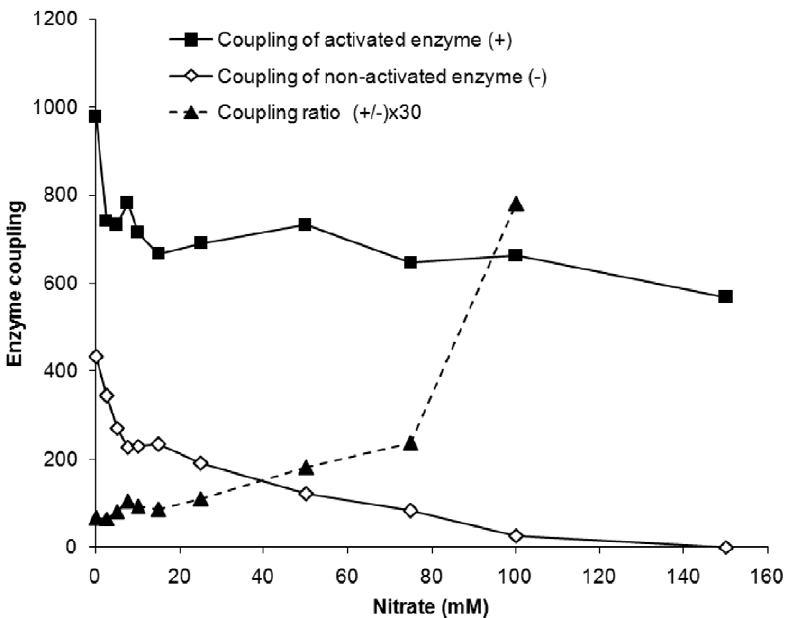
Figure 3. Nitrate inhibition of the coupling capacity of the activated and non-activated V H + -ATPase of the yeast TM revealed the higher coupling and higher stability of the activated pump. The coupling capacity (V 0 /ATPase) is given as a percentage of the fluorescent quenching/ m mol ATP.